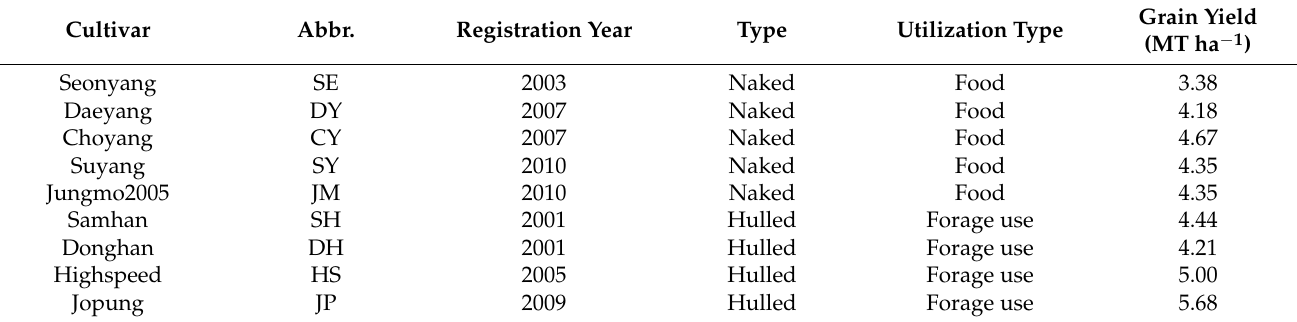
Table 5. Characteristics of the oat cultivars used in this